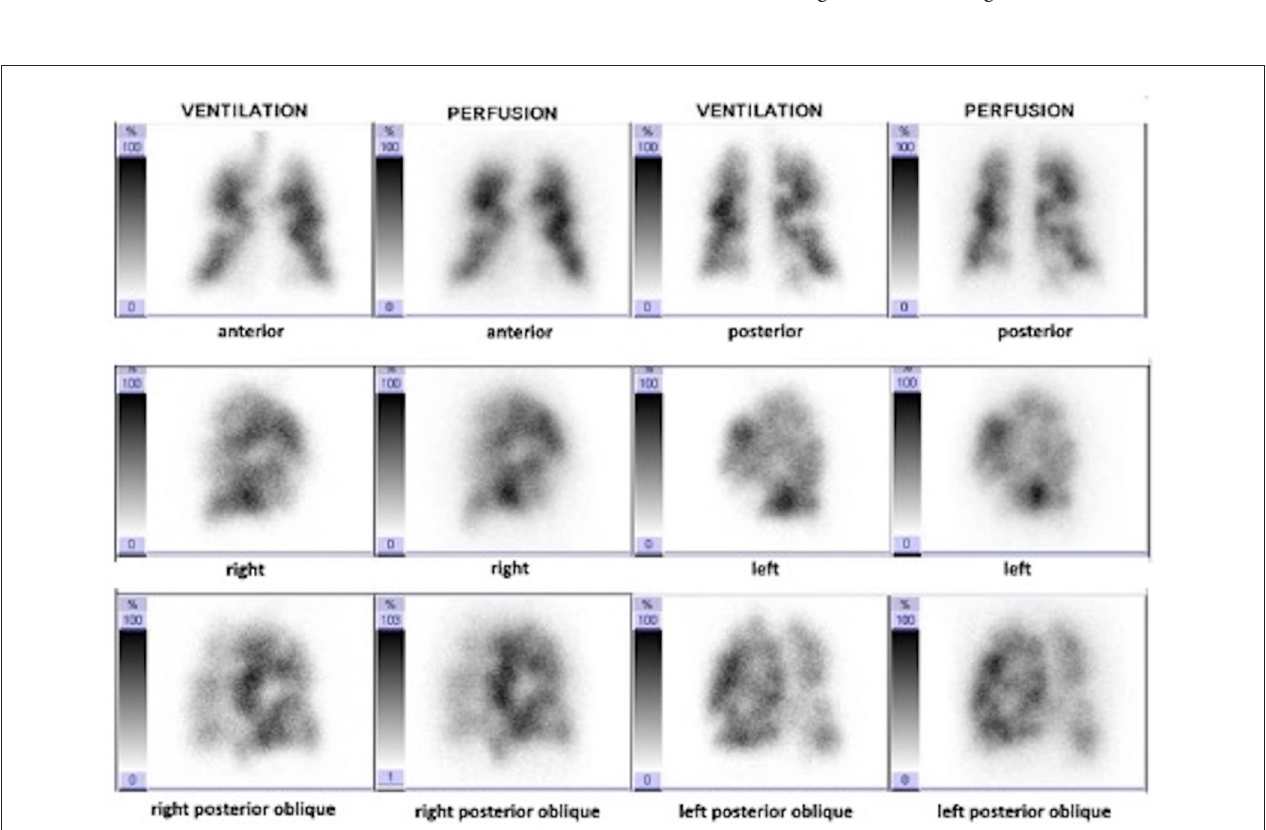
FIGURE 4 | Planar V/Q scan showing multiple perfusion defects matched with ventilation impairments: final diagnosis was a PH classified as mix from group 1, 2 and 3 of PH classification, which was confirmed during the follow-up.